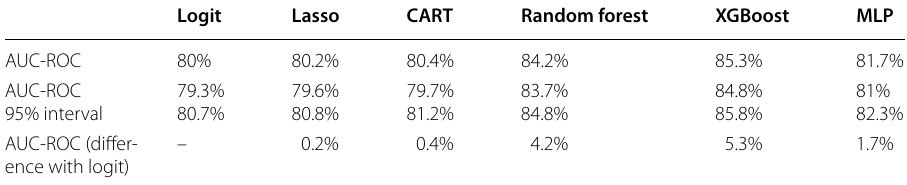
Table 7 Results of the estimated AUC-ROC using “Give Me Some Credit” dataset Logit